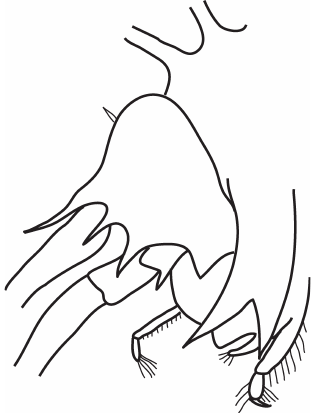
Fig. 2. Lepechinella arctica Schellenberg, 1926 ( Dorbanella sp.), head redrawn after Schellenberg